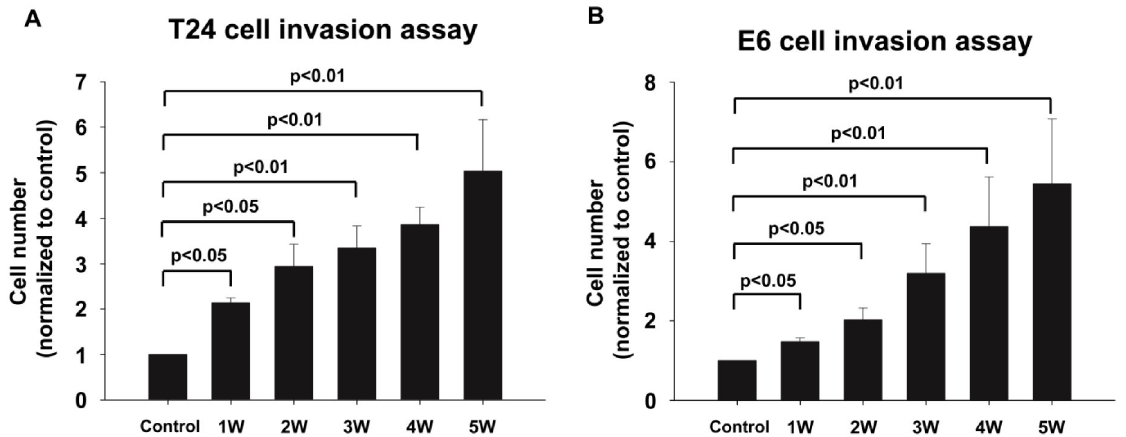
Figure 3. Hydronephrotic urine promoted invasive capability of T24 cells and E6 cells. Hydronephrotic urine from 1 to 5 weeks after UUO promoted the invasion of T24 cells and E6 cells. (A, B) T24 cells and E6 cells were cultured in hydronephrotic urine from 1 to 5 weeks after UUO for 12 hrs and plated in the upper compartment of an 8-µm pore-size transwell invasion chamber which was coated with growth factor-reduced materigel and cultured in serum-free medium for 24 hrs. The numbers of invasive cells were determined by Giemsa staining (Control: without hydronephrotic urine treatment).